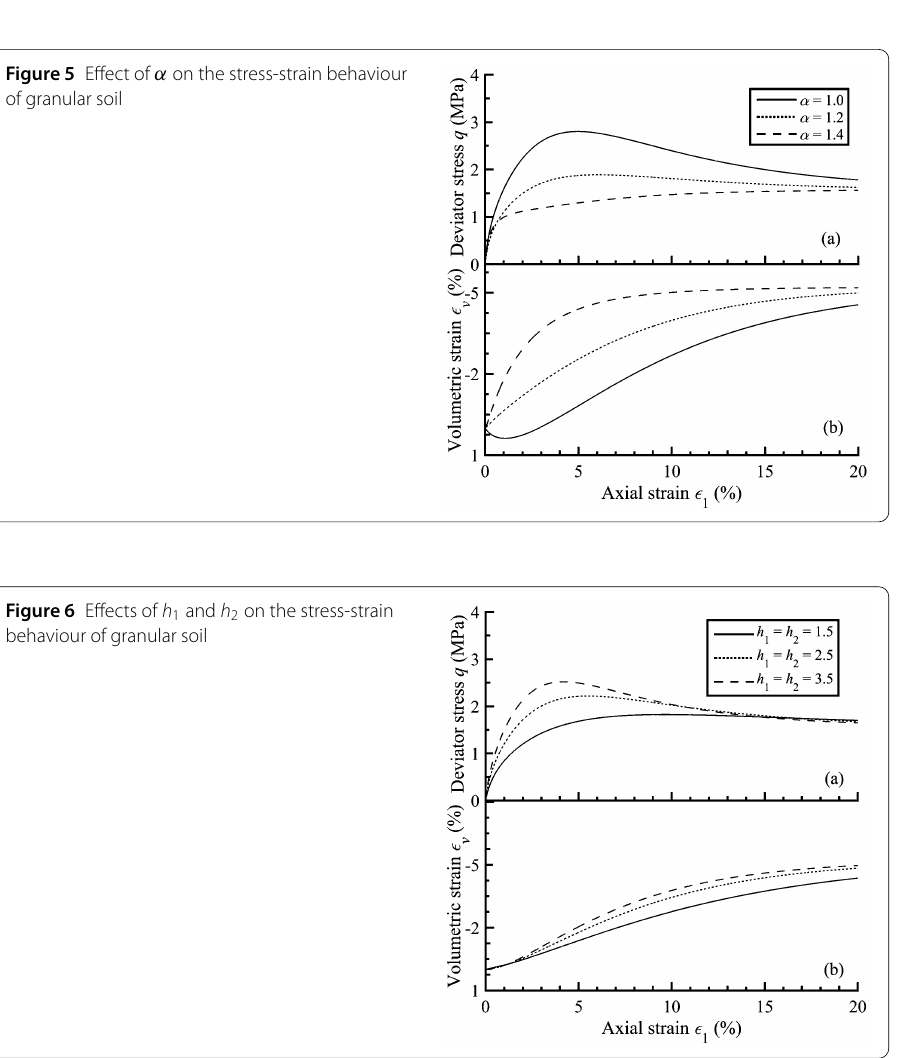
Figure 5 Effect of α on the stress-strain behaviour of granular soil